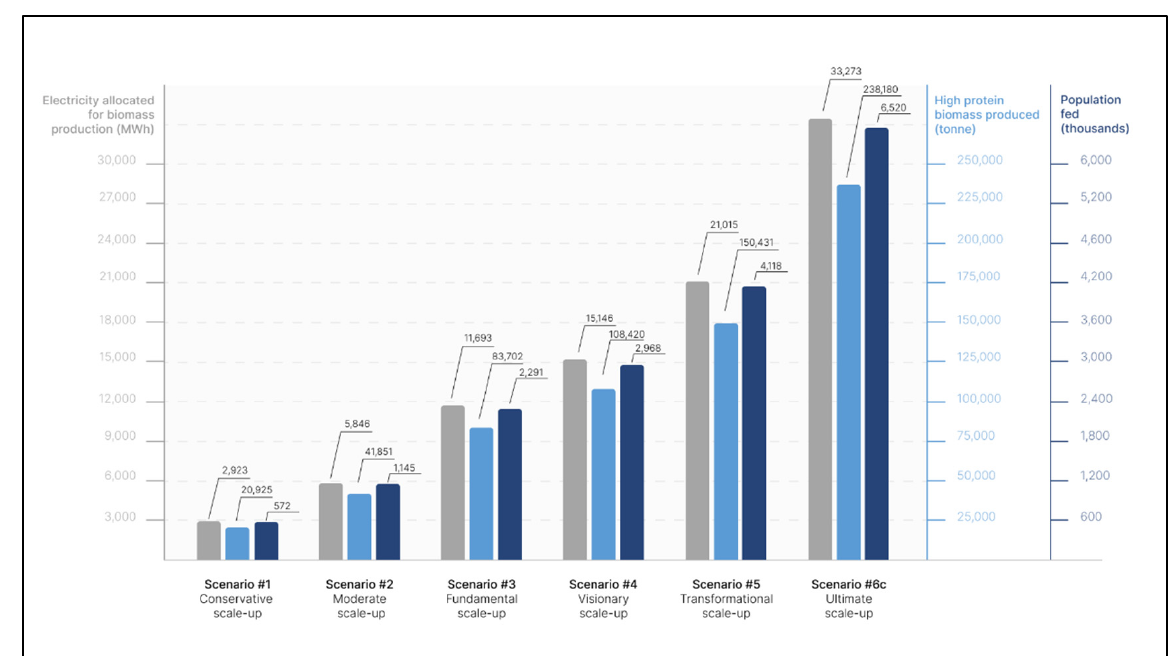
Figure 4. Summary of six high-protein biomass production scenarios as calculated in this study including electricity allocations in MWh, Spirulina biomass production in tonne, and people provided with necessary protein and EAAs in thousands.